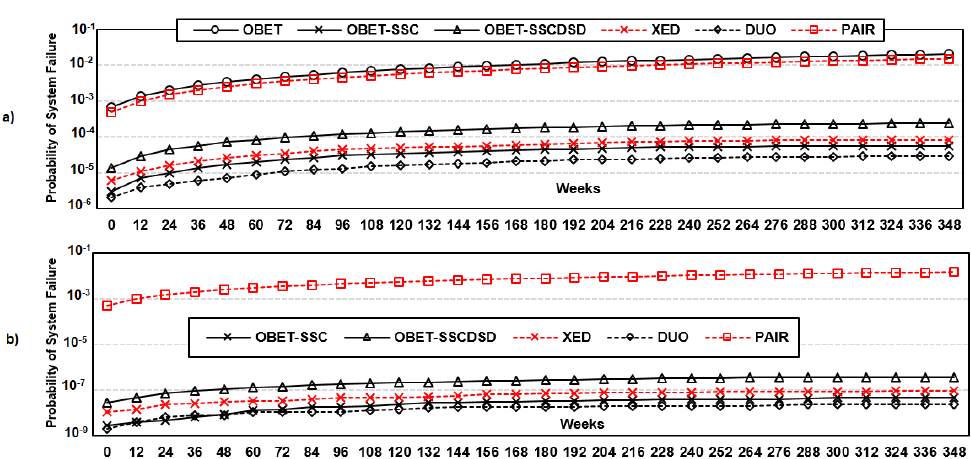
Figure 7. The probability of system failure for state-of-the-art works and OBET-based techniques for a period of 7 years based on Monte Carlo simulations with pattern error [27]: ( a ) removal of transition errors only and ( b ) removal of both transient and permanent errors.